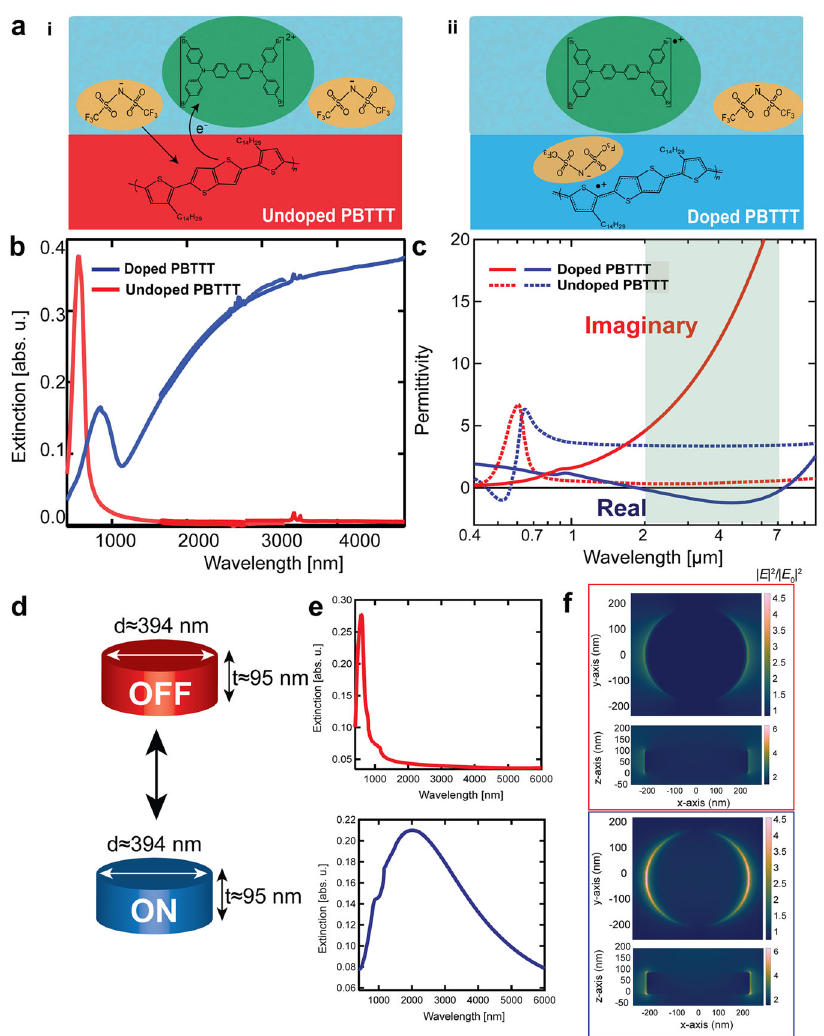
Fig. 1 Concept of doped PBTTT polymer nanoantennas. a Doping mechanism of PBTTT fi lms with the TAB-2TFSI dopant. b Absorption spectra of fi lms made from 1.5 wt% PBTTT (thickness ≈ 60 nm) in the doped (blue) and undoped (red) states. c In-plane permittivity dispersion of PBTTT in its doped (blue curve, real part; red curve, imaginary part) and undoped (dashed blue curve, real part; dashed red curve, imaginary part) states. The spectral range between ≈ 2 and 7 μ m is de fi ned as a metallic regime where the real permittivity is below zero for the doped polymer. d Dimensions of doped and undoped PBTTT nanodisk arrays on glass substrates used to simulate the extinction and near fi eld pro fi les in e and f . e Simulated extinction and f near fi eld response for nanodisk arrays (diameter = 394 nm, thickness = 95 nm, period = 800nm, mesh size = 2 × 2 × 2 nm 3 around the nanodisks) at the resonance peak wavelength of ~2011nm, based on doped (blue) and undoped (red) PBTTT nanodisks. In ( f ), top panels are top views while bottom panels are cross sections of the nanodisks along the direction of the incident polarization, which is along the x -axis. x – y in-plane direction is 2 nm above the nanodisk and x – z cross-section is through the center of the nanodisk. The color scale bars show the square of the electric fi eld strength relative to the incident light (| E | 2 /| E 2 0 |